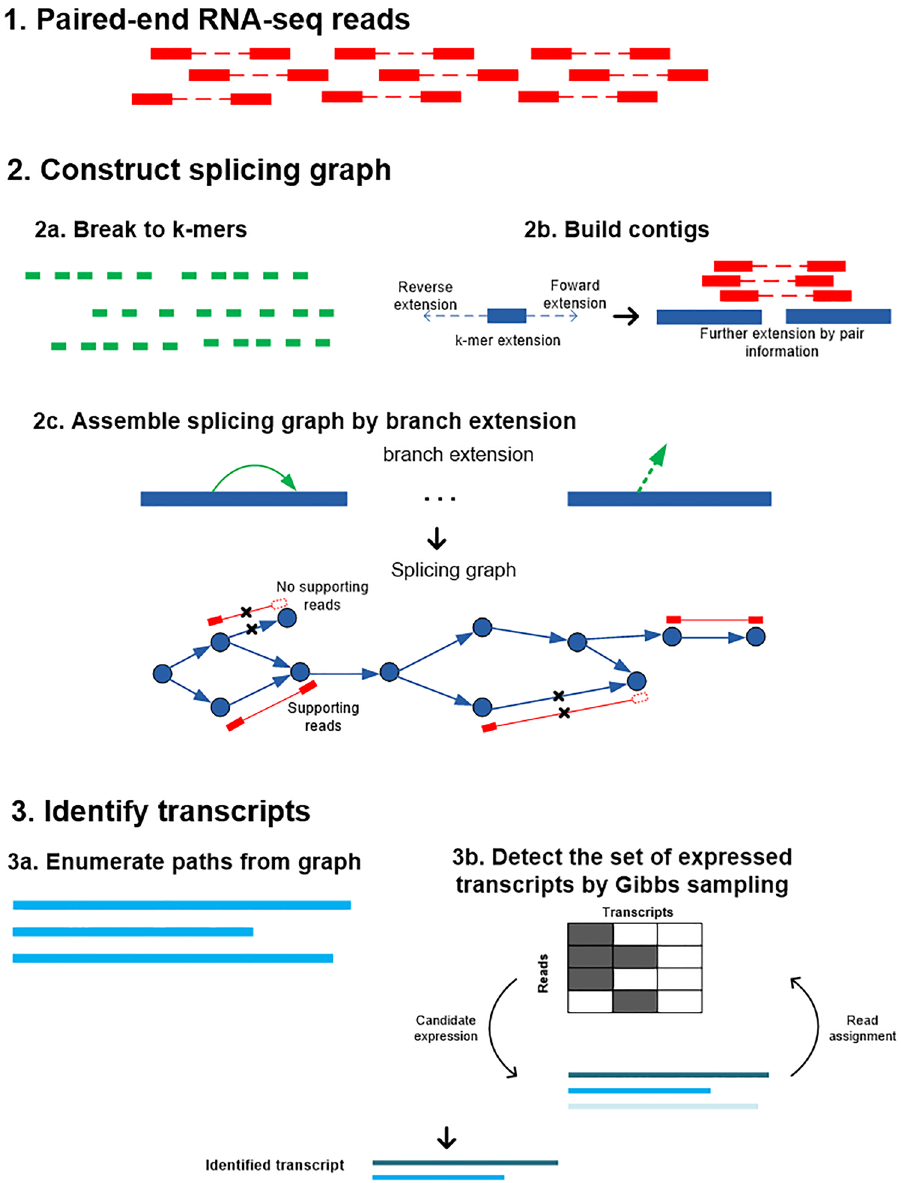
Figure 5. An Overview of the BayesDenovo approach. The approach consists of the following two major steps: (1) splicing graph construction from short RNA-seq reads; (2) transcript estimation from the splicing